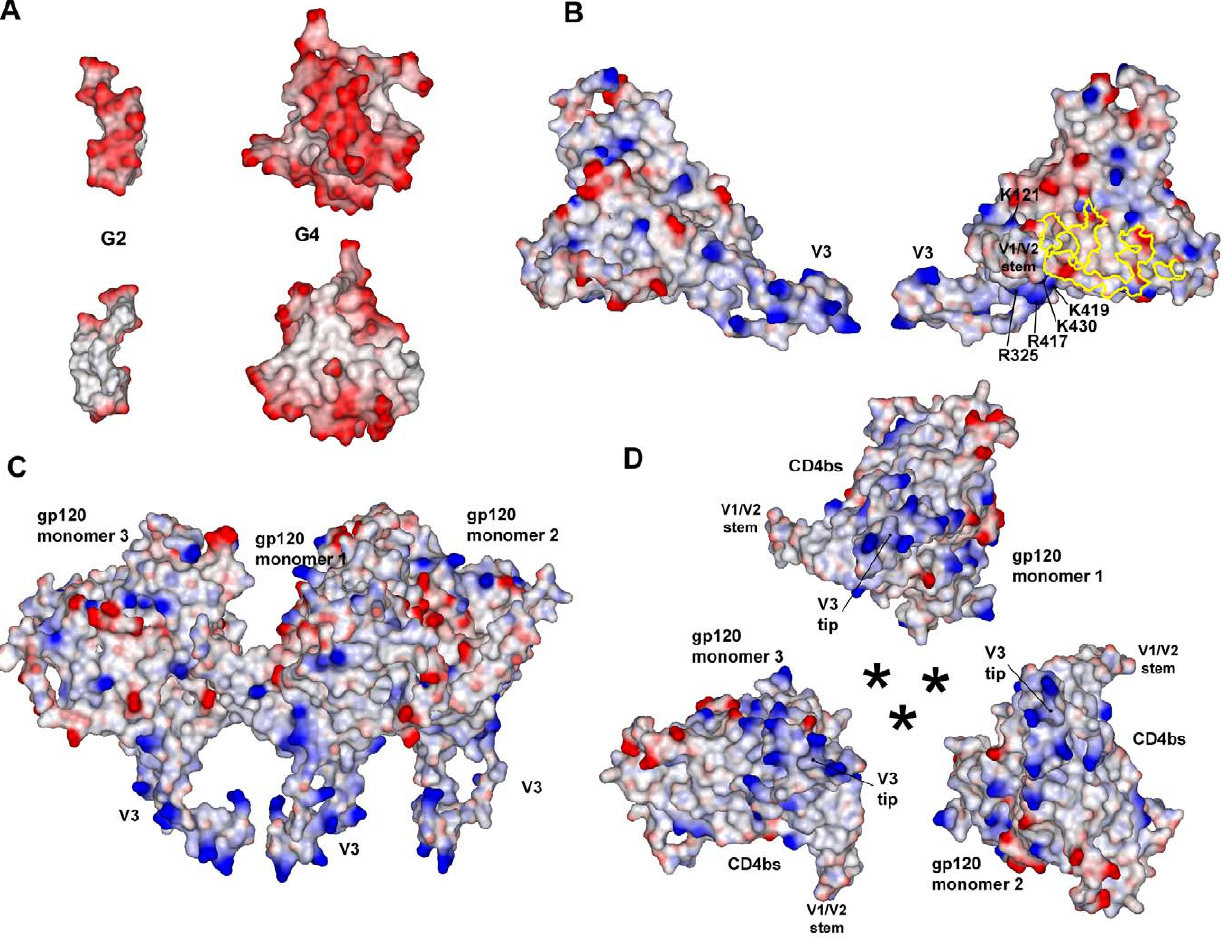
Figure 5. Electrostatic surface views of dendrimer and gp120 models. ( A ) Models of the G2 (SPL7115) and G4 (SPL7013) dendrimers taken from the last frame of a molecular dynamics simulation [31]. Two views are shown (top and bottom) rotated by 180 u around the long axis of the dendrimer. ( B ) Two views (rotated by 180 u ) of the homology model of the DRNL wild-type gp120. CD4 binding site is denoted by a yellow outline and conserved residues K121, R325, R417, K419 and K430 in the CD4i domain are indicated. ( C ) Side-view of the DRNL gp120 trimer with the V3 loops pointing towards the target cell membrane. The space between the gp120 monomers would normally be occupied by gp41. ( D ) End-on view of the DRNL gp120 trimer with the V3 loops facing the viewer. Predicted position of gp41 monomers are marked by an asterisk. In all views, the solvent- accessible surfaces are mapped with regions of negative (red) and positive (blue) electrostatic potential (charge).